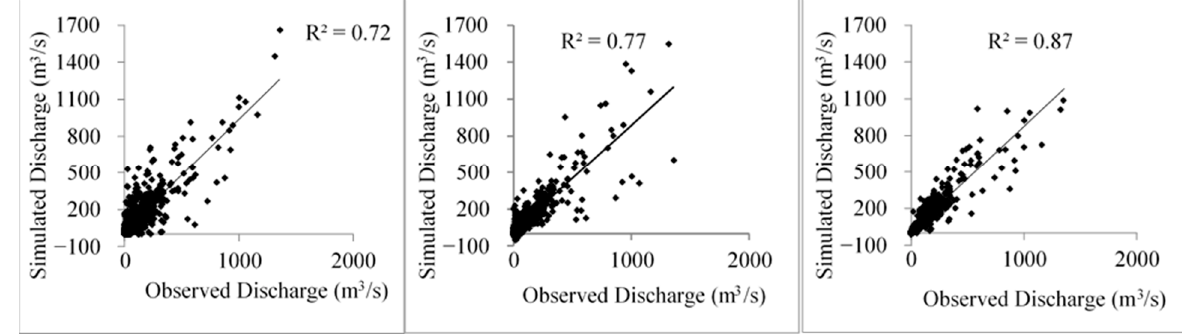
Figure 12. Scatter plot of daily simulated and observed discharge for SWAT ( left ), ARX ( middle ), and GEP ( right ) during the validation period (2008–2010) at LD14.